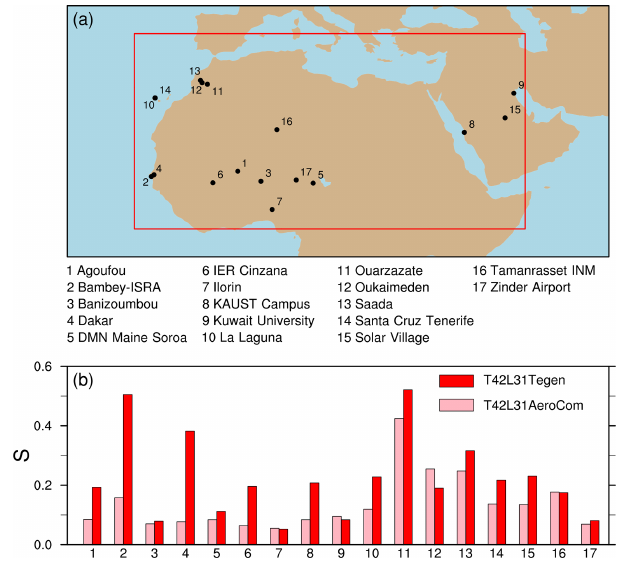
Figure 4. Locations of selected AERONET stations and skill scores for the T42L31AeroCom and T42L31Tegen setups. (a) AERONET stations in the region of 5–40 ◦ N, 20 ◦ W–50 ◦ E (red box), for the time period 2009–2013, with Ångstrom exponents of AE < 0 . 75 (AE averaged over the time period 2009–2013) and a minimum of 50 observation days were selected. (b) Skill scores ( S ) for these stations are calculated from AOD observations and model output for the T42L31AeroCom (pink bars) and T42L31Tegen setup (red bars),